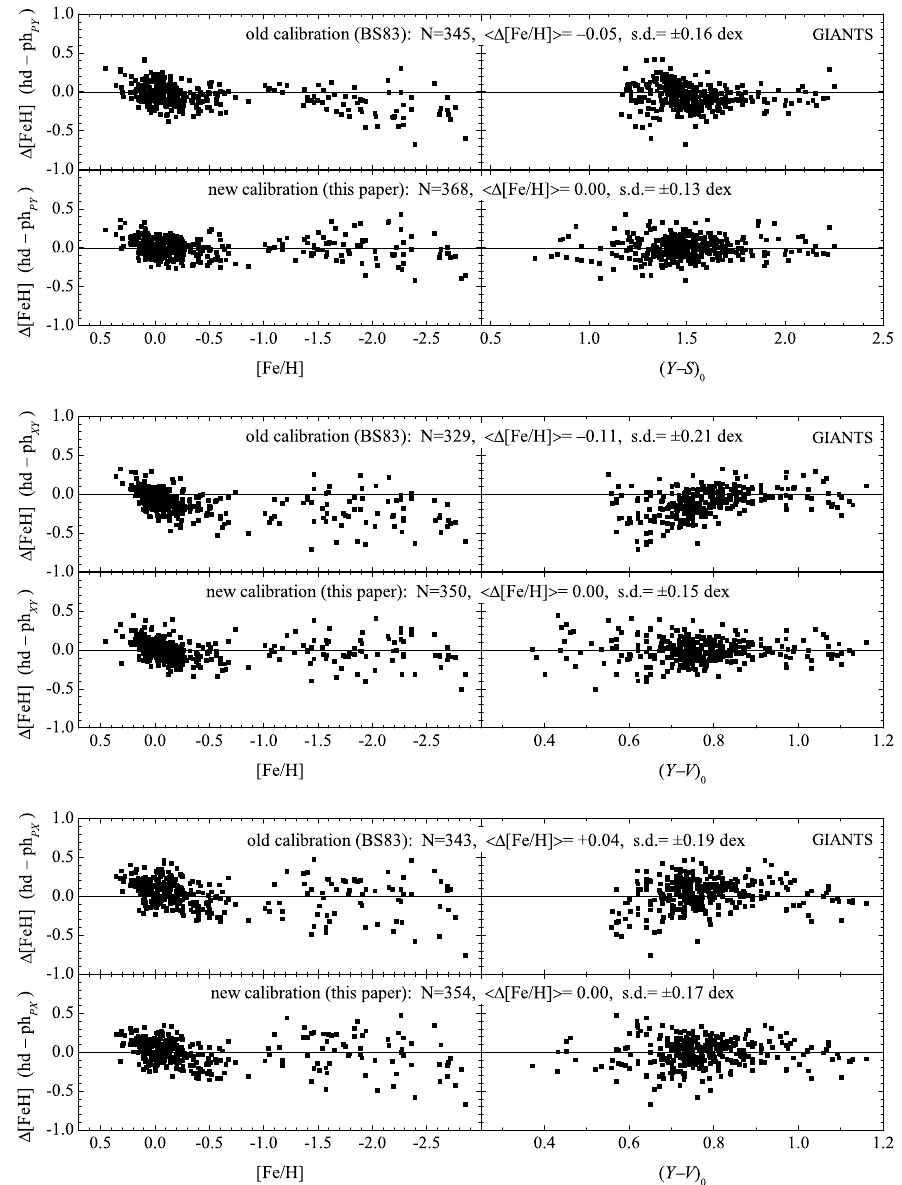
Fig. 9. Differences between [Fe/H] from high-dispersion spectroscopy and [Fe/H] from old (BS83) and new calibrations of Vilnius photometry for the same set of giant stars, shown as functions of [Fe/H] (left-had panels) and temperature-dependent color indices (right-hand panels). The number of stars compared, mean residuals and standard devi- ations are given on the top of each